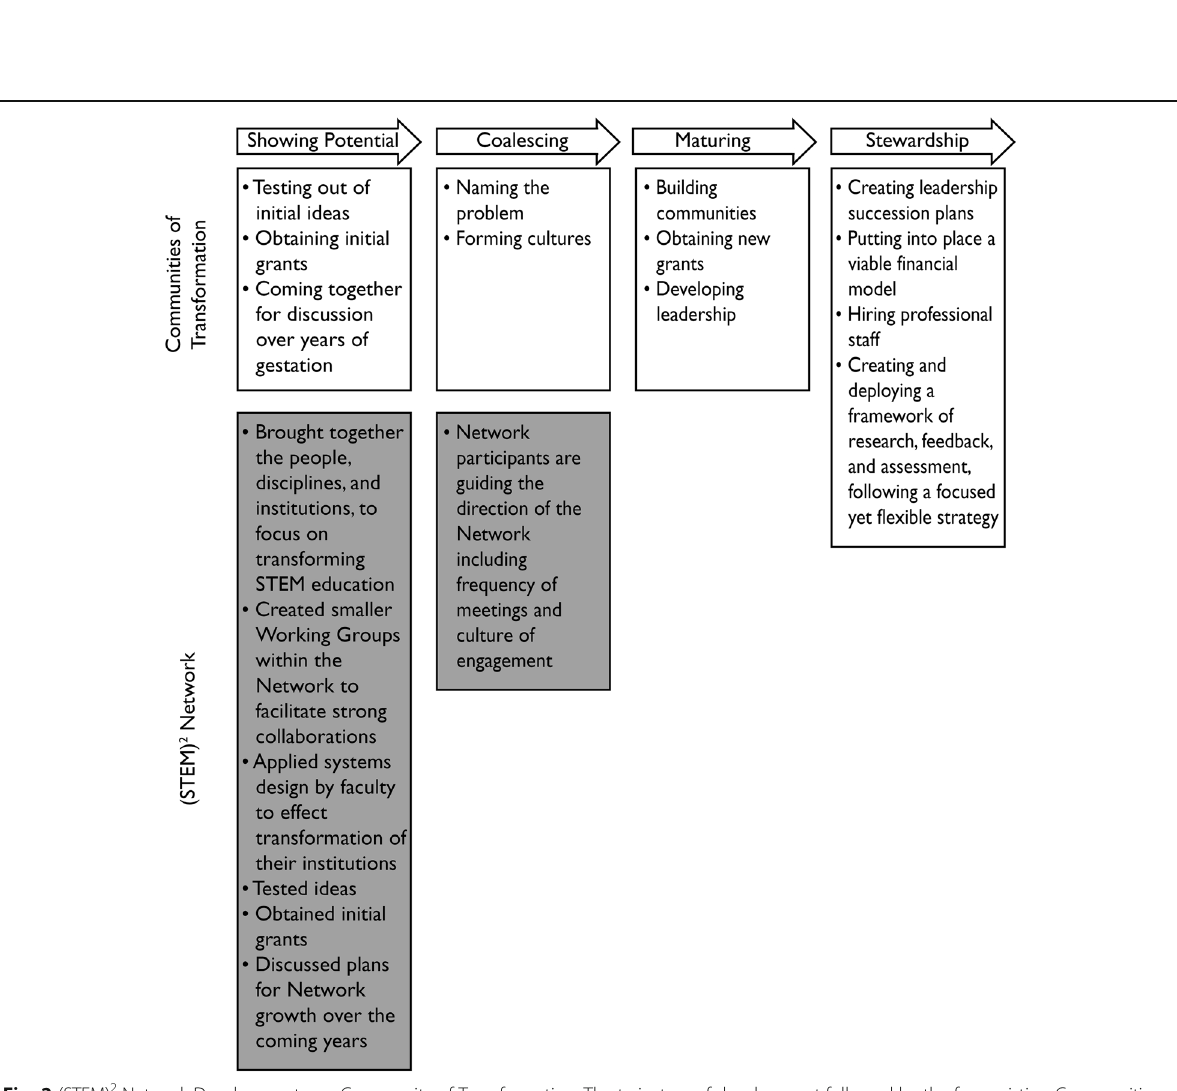
Fig. 2 (STEM) 2 Network Development as a Community of Transformation. The trajectory of development followed by the four existing Communities of Transformation (adapted from Kezar & Gehrke, 2015) aligned with development, to date, of the (STEM) 2